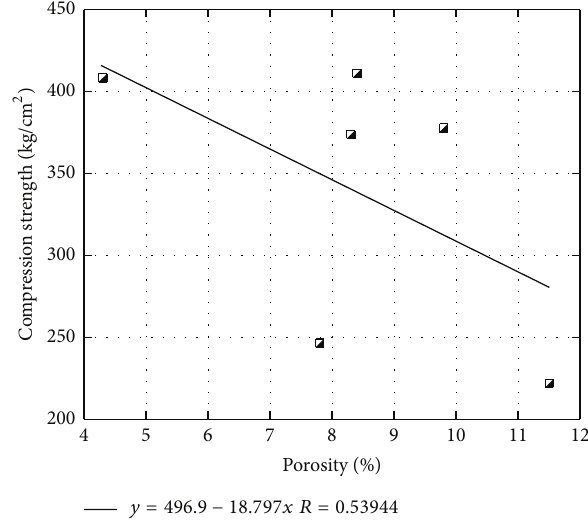
Figure 14: Correlation between porosity and compression strength for all trains.